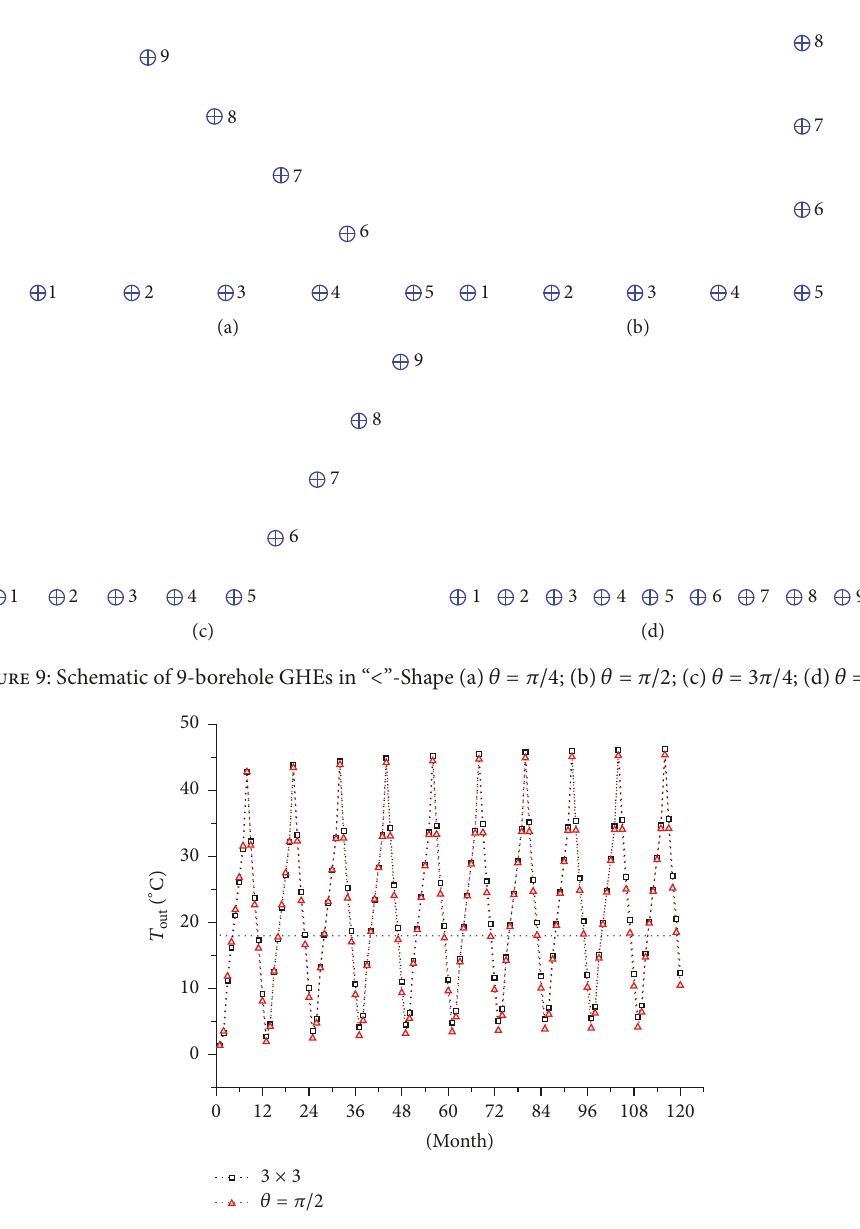
Figure 10: Monthly average GHEs outlet fluid temperature ( 𝜃 = 𝜋/2